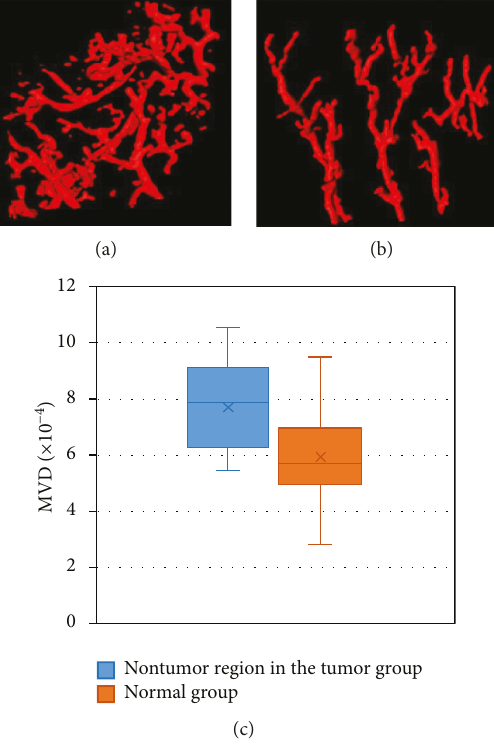
Figure 6: MVD comparison between nontumor region in the tumor group and the normal group. (a) One VOI of nontumor region in the tumor group; (b) one VOI of the normal group; (c) MVD statistics of the two groups ( n = 10 per